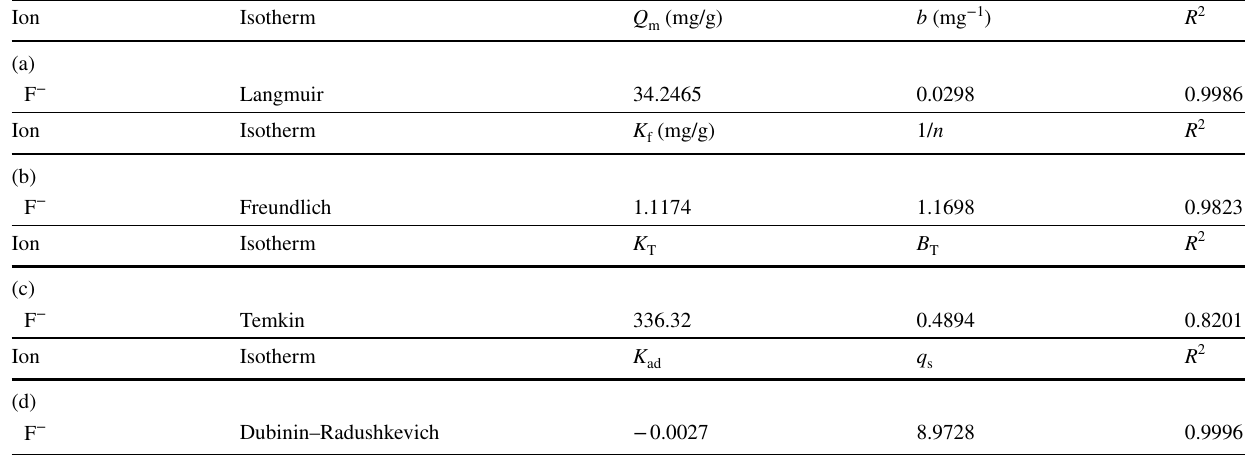
Table 3 a–d Parametric study of Langmuir, Freundlich, Temkin and D–R isotherms of BISAB at 333 K Ion